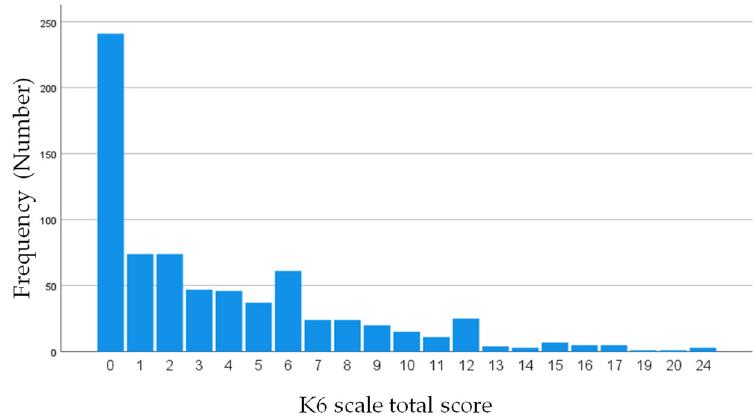
Figure 3. Distribution of adolescents’ six-item Kessler Psychological Distress Scale scores. We examined the correlations between adolescent mood and anxiety disorders and the other variables in the hypothetical model (Table 3). There was no significant gender difference in mood and anxiety disorders (r = − 0.03, p = 0.42). Latent variables were determined by the following procedure. First, we excluded somatic symptoms without “headache” and “fatigue” from the analysis because less than 5% of respondents indicated such difficulties. Then, we defined the latent variable “vitality” using two variables because fatigue ( p < 0.001) and headache ( p < 0.001) had slightly stronger significant correlations with adolescent mood and anxiety disorders than the other